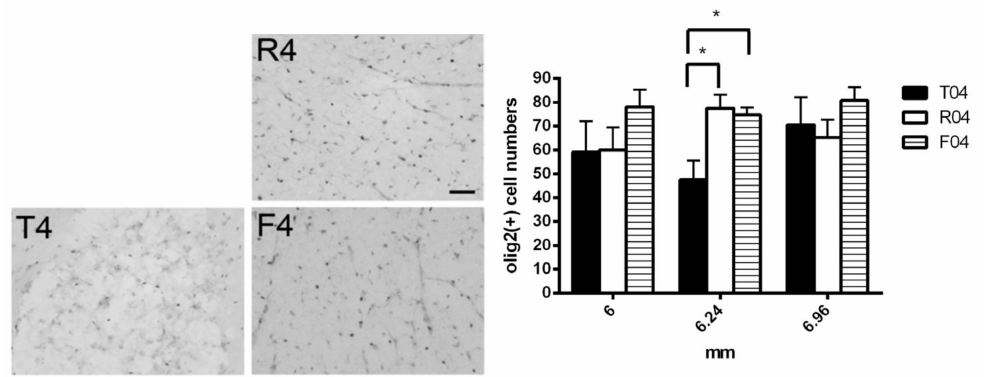
Figure 3. A cross-section near 6 mm from the trauma center showing the cells around the center cavity in the dorsal column. OLIG2 was used was a pan oligodendrocyte lineage cell marker. Statistical significance was evaluated using one-way ANOVA and Tukey’s test. Animal number used: T4 (( n = 7), R4 ( n = 5), F4 ( n = 6). * indicate p < 0.05. Scale bar =100 µ